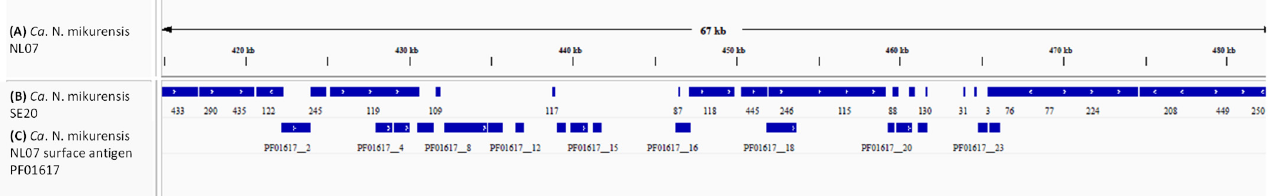
Figure 2. IGV plot indicating ( A ) the full assembly of NL07, ( B ) in blue, the regions of the SE20 assembly that align to NL07 and the gaps that SE20 does not encompass, and ( C ) in blue, the location of repeats of the outer membrane protein repeats belonging to the PF01617 domain in NL07 and SE20. Note that most repeats are present only in NL07.